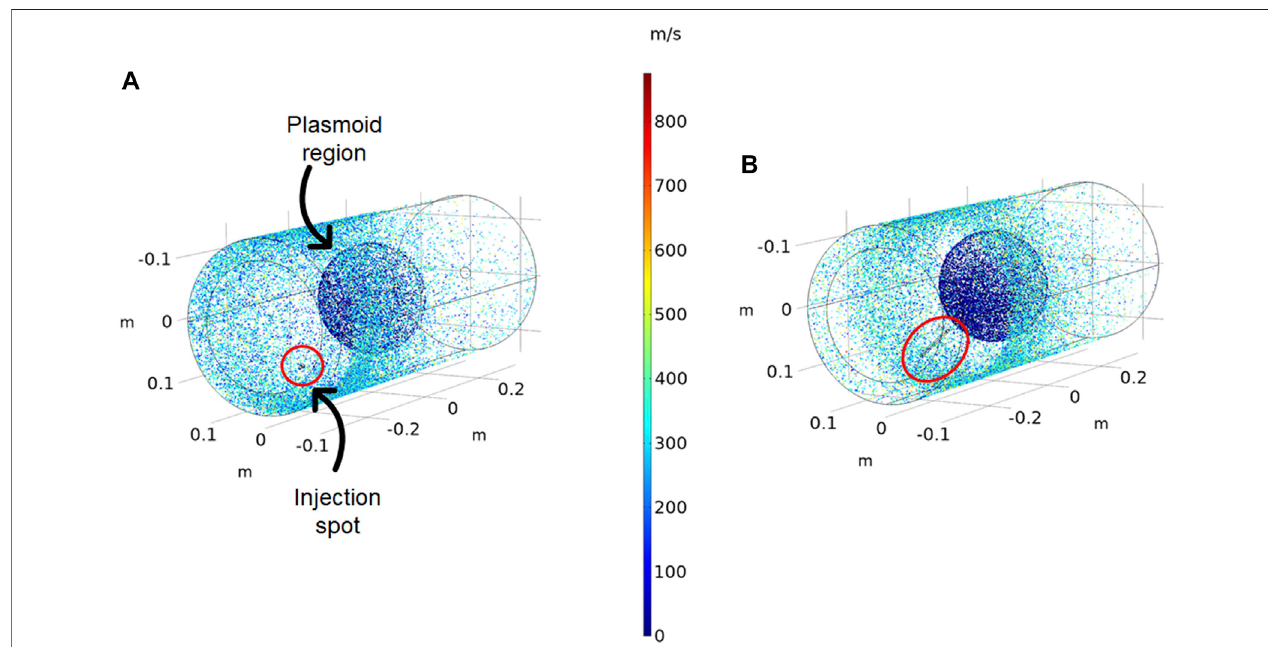
FIGURE 10 | Numerical simulation of particle diffusion of 134 Cs neutral vapours for the PANDORA trap performed using COMSOL Multiphysics ® . (A) 10 mm long STO, and (B) 120 mm long STO, cases. STOs are indicated inside the red circles. Particles ’ speed [m/s] is indicated in the color bar.